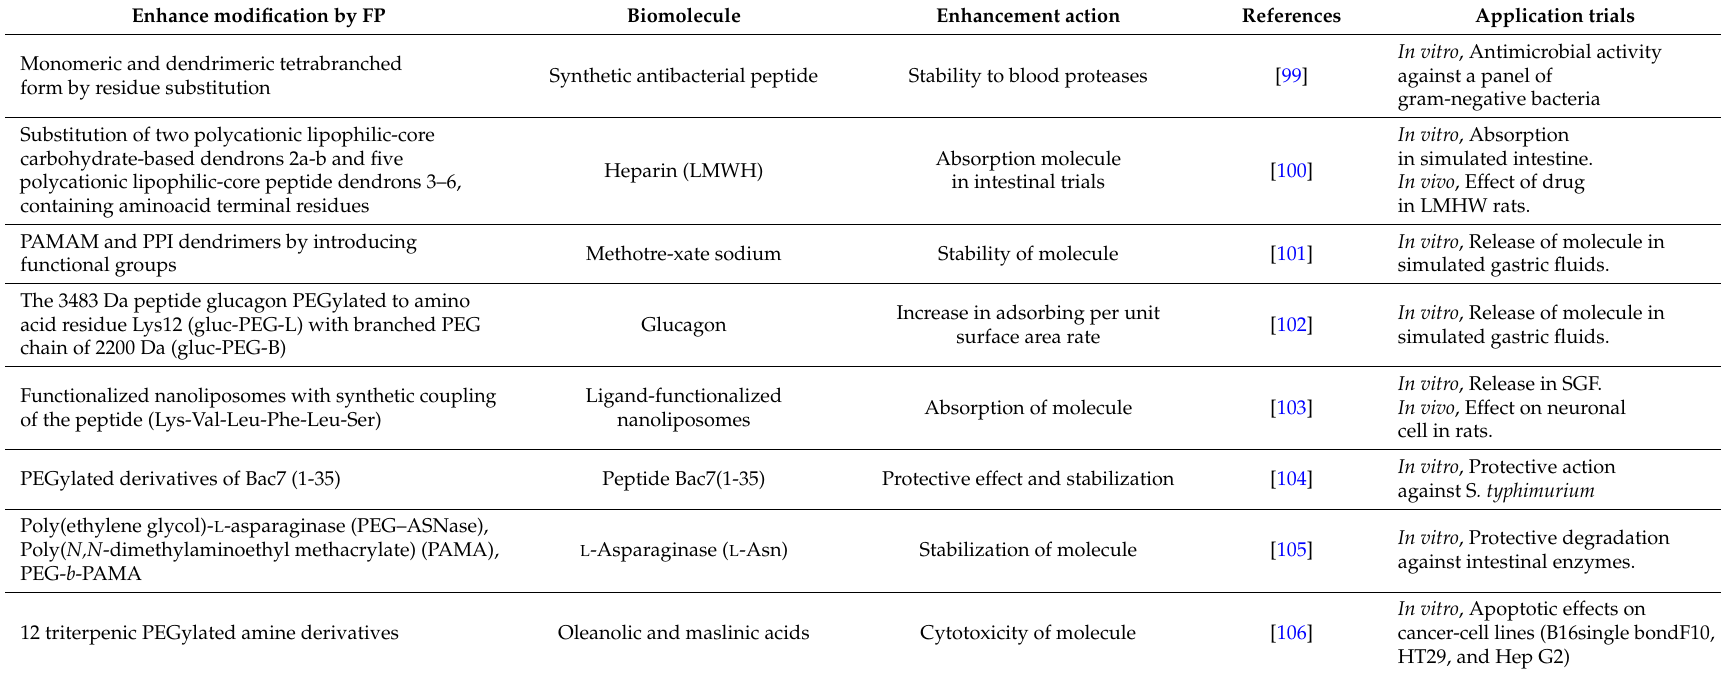
Table 4. Modification of the chemical nature of biomolecules with FP